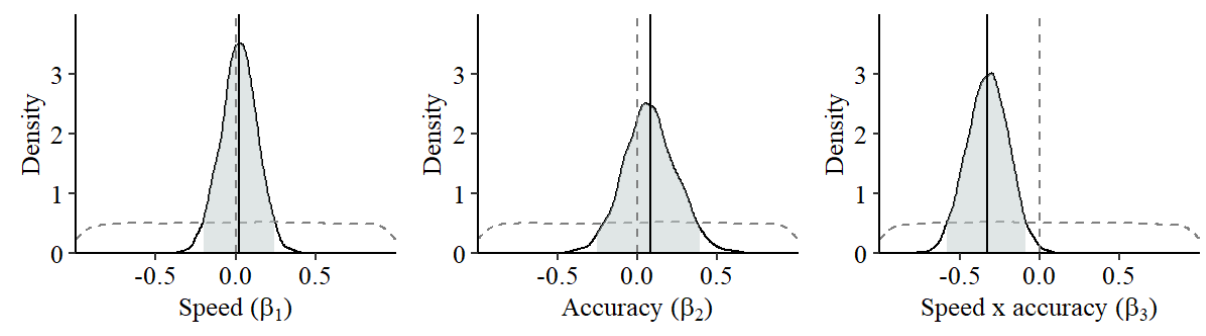
Figure 3. Association between work stress and computer mouse movements. Shown is the estimated effect (posterior and prior density and mean as solid and dashed grey lines, respectively, and 95% highest posterior density interval as shaded area) of mouse speed ( β 1 ), mouse accuracy ( β 2 ), and the two-way interaction between mouse speed and accuracy ( β 2 ).